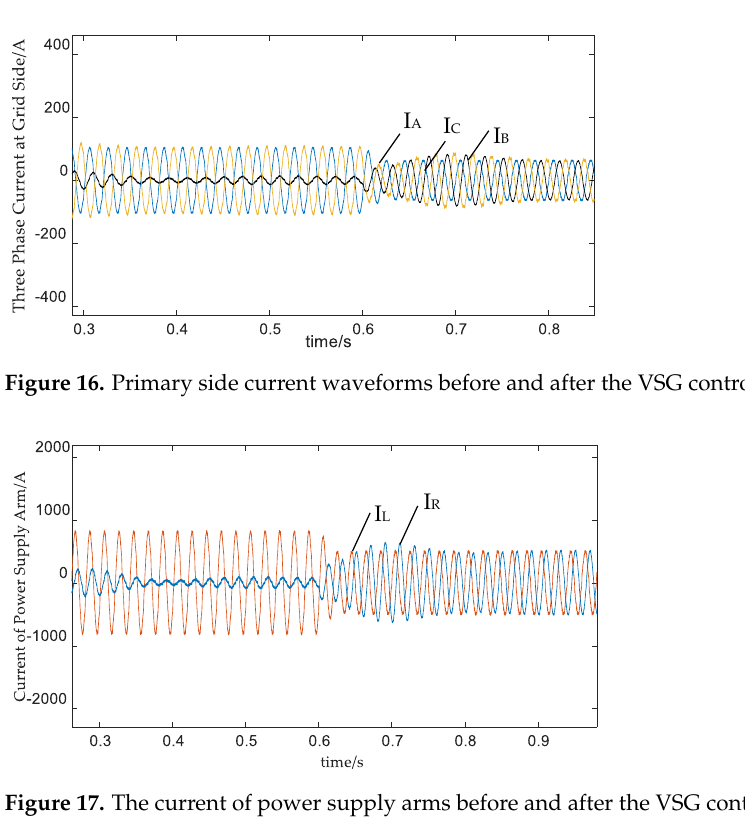
Figure 17. The current of power supply arms before and after the VSG control was adopted.